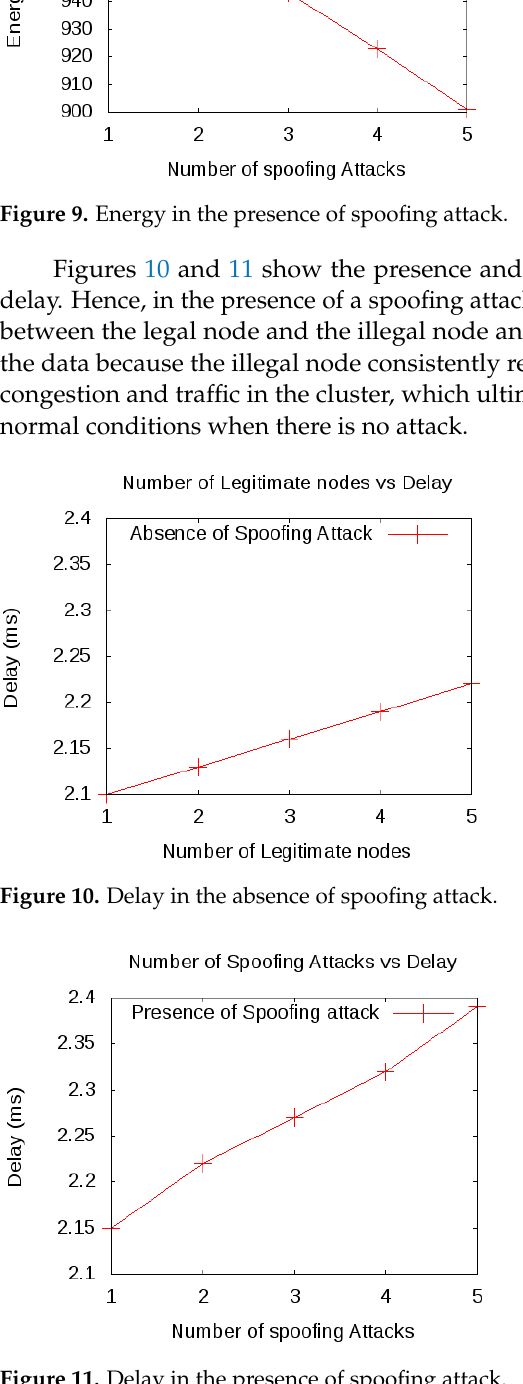
Figure 9. Energy in the presence of spoofing attack.